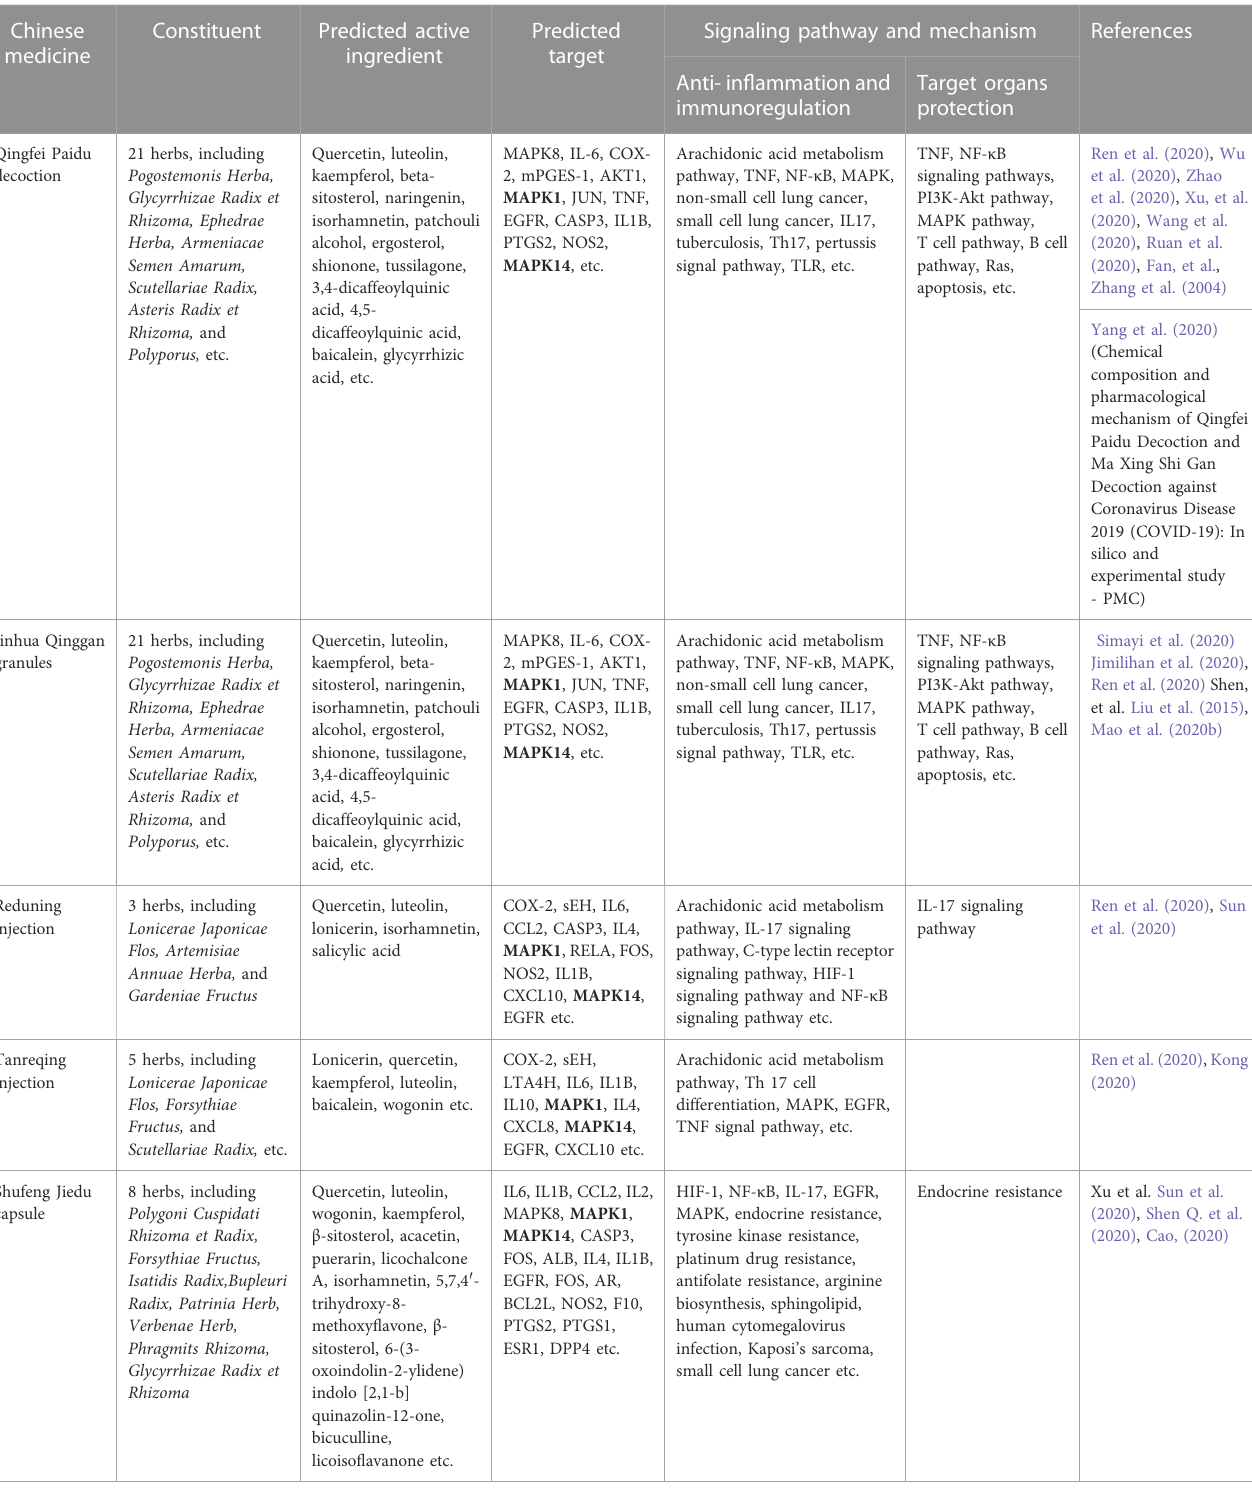
TABLE1StudyonthemechanismofactionoftraditionalChinesemedicinerecommendedbyChinaCOVID-19guidelinesfordiagnosisandtreatmenttargetingMAPK1/